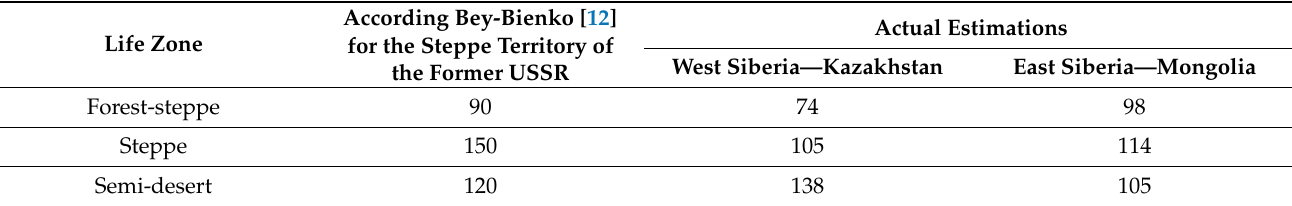
Table 1. Estimation of species richness in different parts of the Eurasian steppes. Life